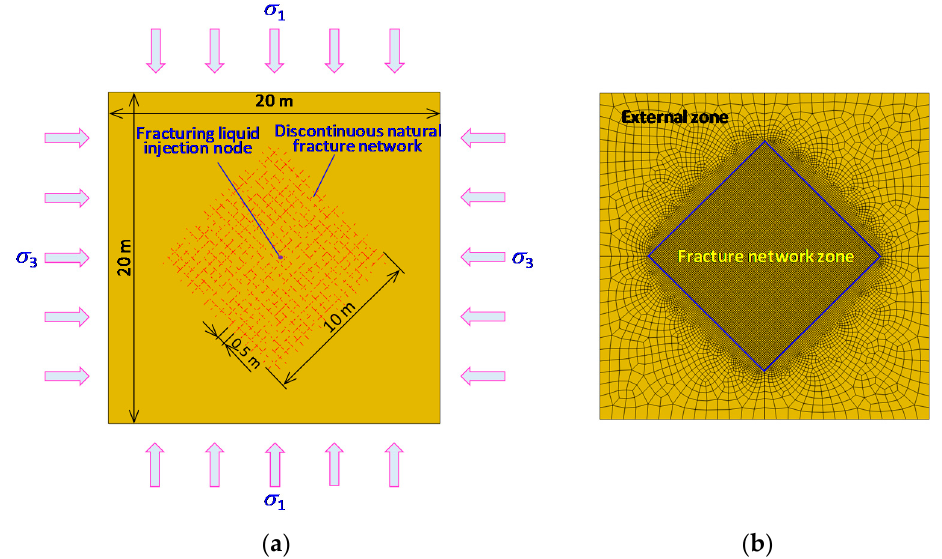
Figure 7. The mesh model of coal seams with discontinuous natural fracture networks. ( a ) shows the model size and the locations of the discontinuous natural fracture network and the injection node; ( b ) shows the mesh density. The fracture network zone is at the center of this model, with a size of 10 m × 10 m. The two fracture sets are orthotropic with each other, and their bisector is parallel to the principle stress direction. The fracture spacing is set to 0.5 m. The fracture network zone’s mesh consists of 10,000 pore fluid/stress elements of size 0.1 m and 20,200 CPPEs. The external zone’s mesh consists of 5612 pore fluid/stress elements of size 0.1 m to 0.6 m.